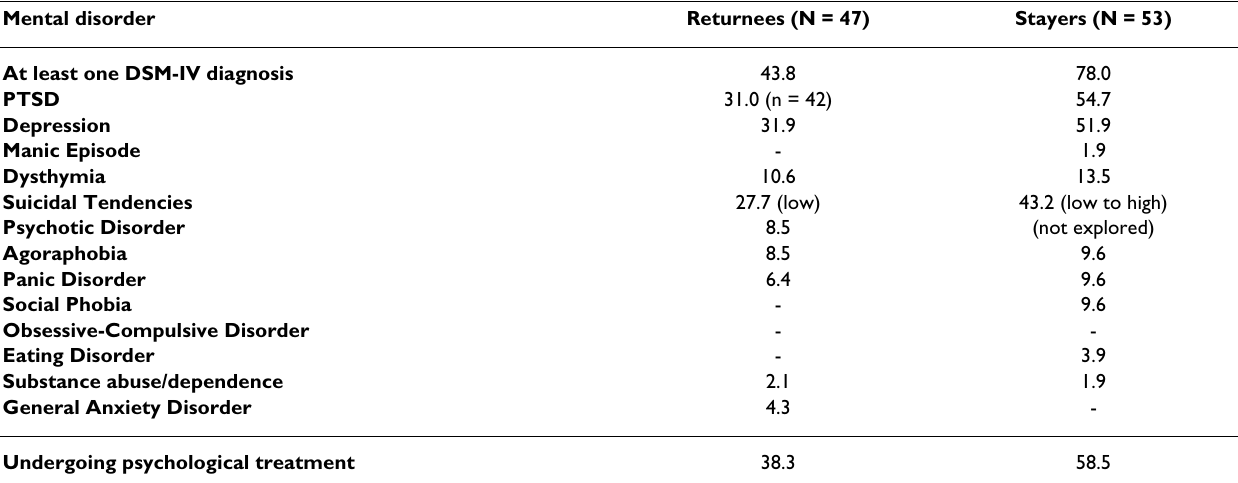
Obsessive-Compulsive Disorder Eating Disorder Substance